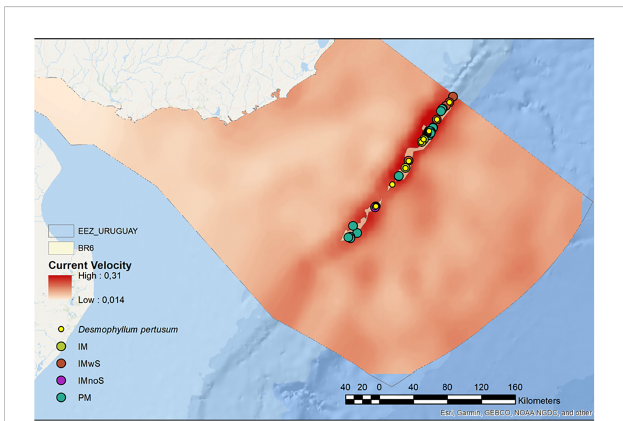
FIGURE 5 Benthic Region 6 (BR6, Inner Upper Bathyal) for the Uruguayan EEZ, showing the association of cold-water corals with high bottom current velocities. IM = Isolated Mound; IMwS= Isolated mound with scarpment; IMnoS= Isolated mound whithout scarpment and PM=